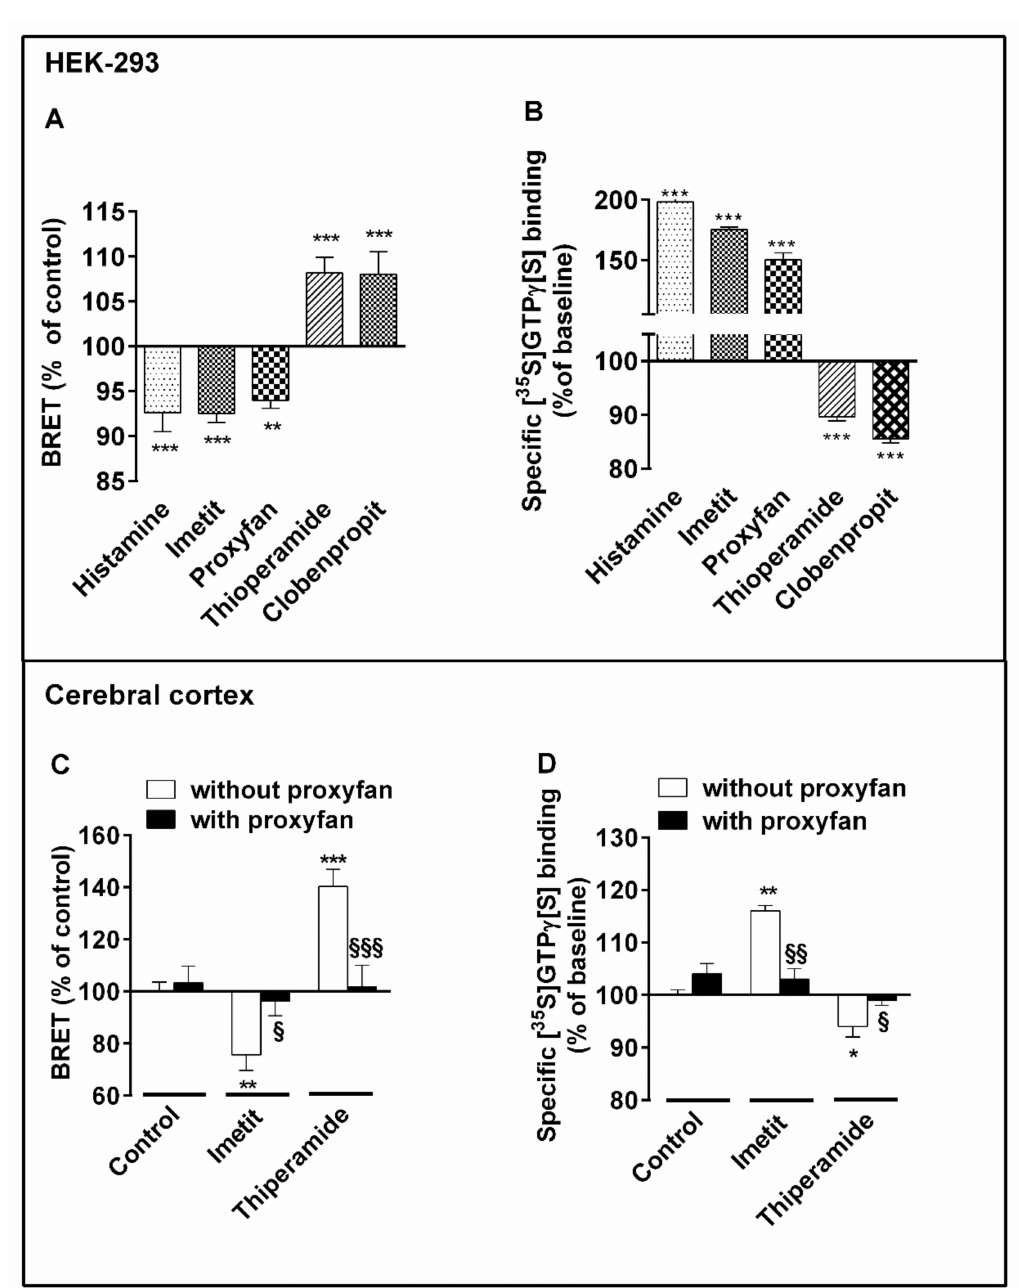
Figure 6. Effects of H 3 -receptor ligands on BRET signals and H 3 R-mediated [ 35 S]GTP γ S binding in HEK 293 cells and rat cerebral cortex. ( A ) HEK 293 cells expressing H 3 R-RLuc and H 3 R-YFP (200–500 fmol per mg protein; sub-maximal BRET) were incubated with the indicated H 3 R ligands (100 nM) ** p <0.01, *** p < 0.001 versus control ( B ) For [ 35 S]GTP γ S binding assays, membranes from HEK 293 cells expressing the H 3 R (200–500 fmol per mg protein) were incubated with H 3 ligands at 100 nM. Means ± SEM of 8–16 values from two experiments. *** p < 0.001 versus control. ( C ) Cultured cortical neurons expressing H 3 R-RLuc and H 3 R-YFP were incubated with H 3 ligands (100 nM) in the absence or presence of proxyfan (10 µ M). Means ± SEM of 15–30 values from five separate experiments. ** p < 0.01; *** p < 0.001 versus control; § p < 0.05; §§§ p < 0.001 versus without proxyfan. ( D ) [ 35 S]GTP γ S binding assay was performed on membranes from the cerebral cortex of adult rats without or with H 3 ligands at 100 nM. Means ± SEM of 8–16 values from two experiments. * p < 0.05; ** p < 0.01; versus control; § p < 0.05; §§ p < 0.05 versus without